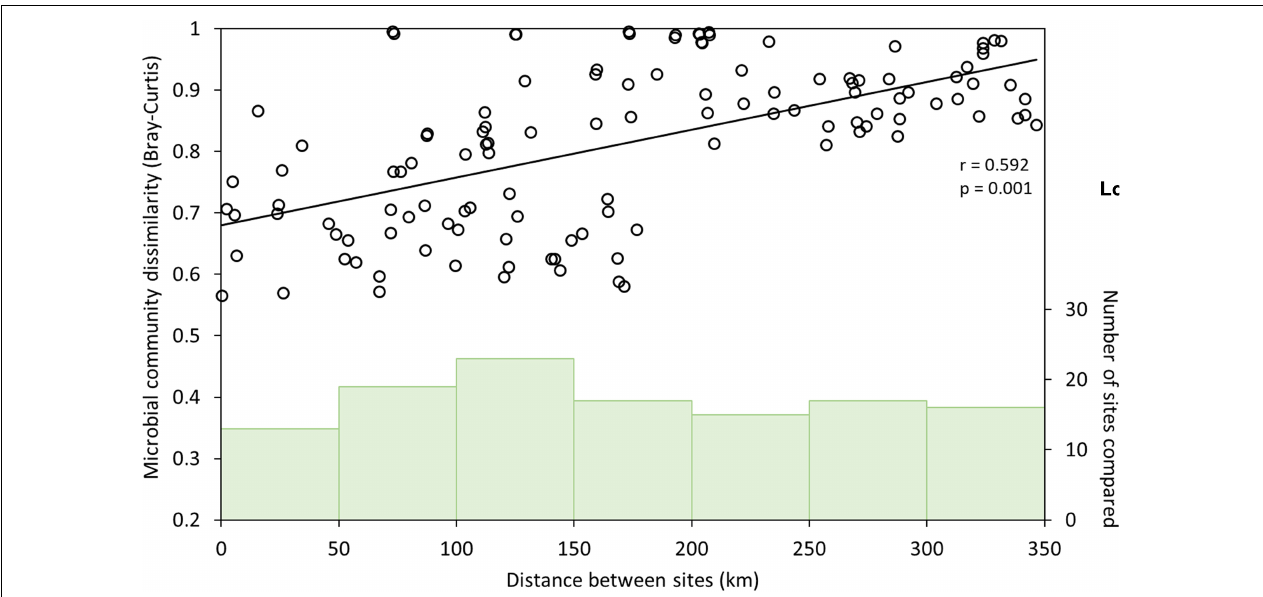
FIGURE 2 | Correlation between microbial community dissimilarity (Bray-Curtis; left y -axis) and geographical distance among sampling sites (open circles, n = 120). Correlation strength and significance were determined from Mantel tests; line indicates regression line between microbial community dissimilarity and geographical distance. Green vertical bars indicate number of sites compared (right y -axis) in each distance category (0–50 km, 50–100 km, 100–150 km, 150–200 km, 200–250 km, 250–300 km, 300–350 km apart) along the x -axis.